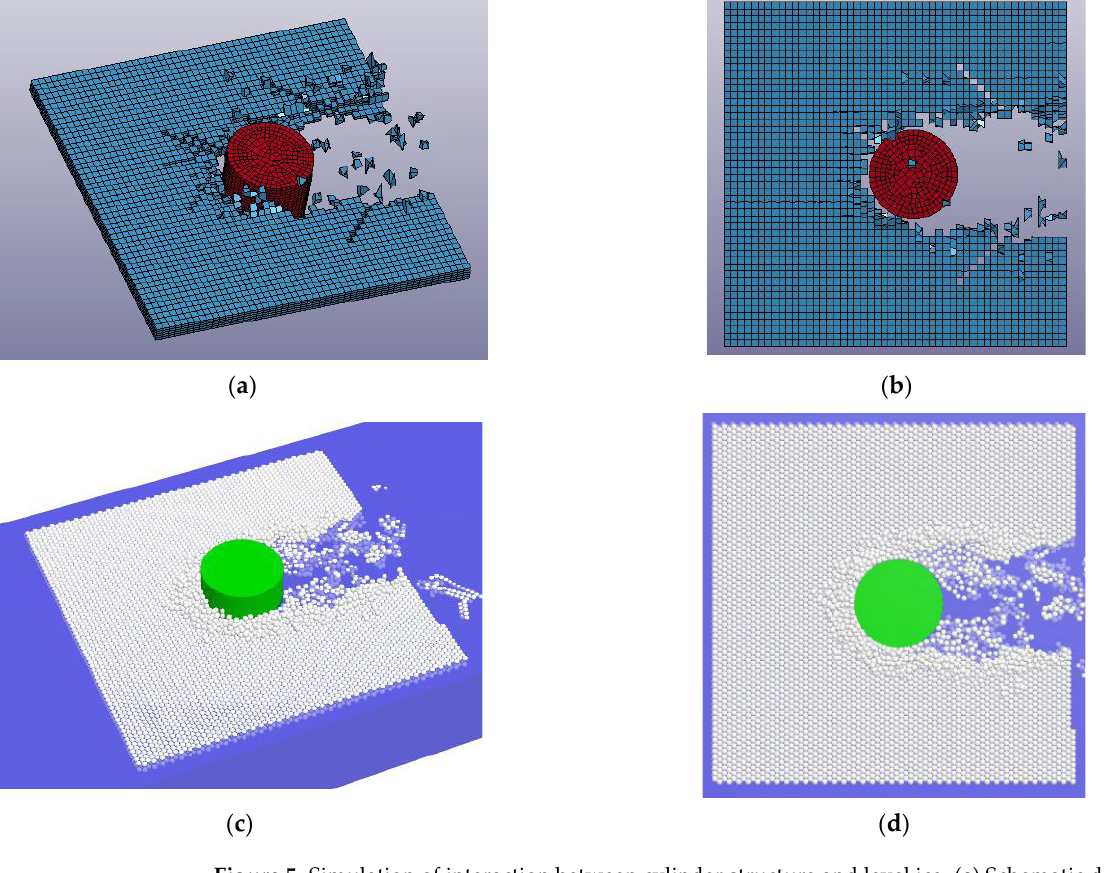
of finite element method calculation; ( b ) top view of finite element method calculation; ( c ) schematic diagram of discrete element method calculation; ( d ) top view of discrete element method calculation.